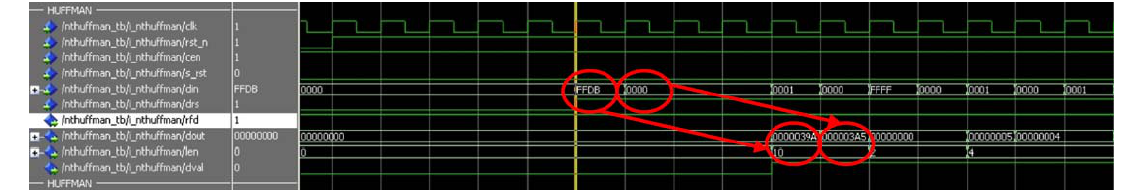
Figure 5. Compression module Input/Output block timing. Start of block.